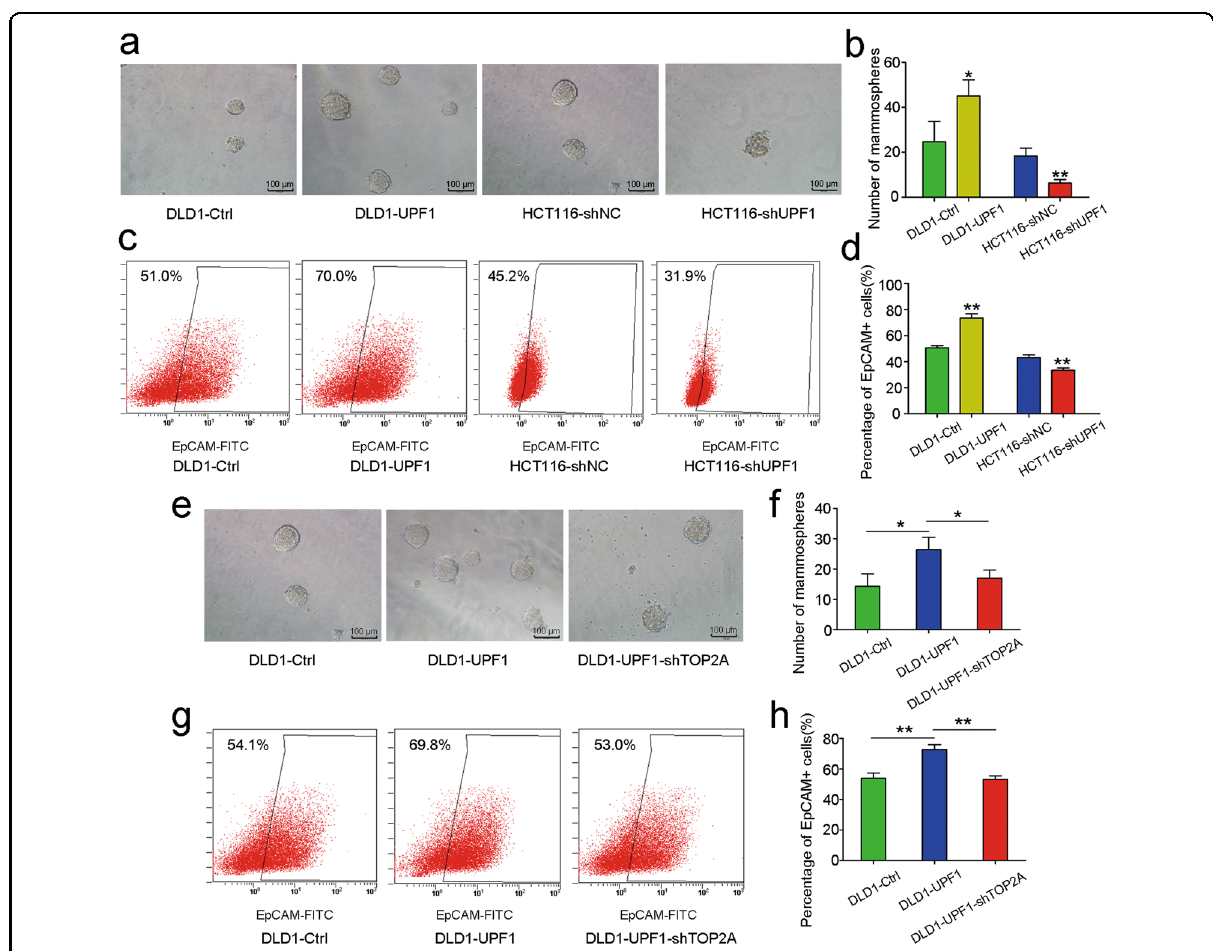
Fig. 7 UPF1 maintains stemness in CRC in a TOP2A-dependent manner. a – b The ability of mammosphere formation was enhanced after upregulation of UPF1 in DLD1 and was attenuated after knockdown of UPF1 in HCT116, scale bar, 100 μ m. c , d The percentage of EpCAM-positive cells was raised in DLD1-UPF1 and diminished in HCT116-shUPF1 compared with control. e – f Silencing TOP2A abrogated enhancement of the ability of mammosphere formation induced by UPF1, scale bar, 100 μ m. g , h Silencing TOP2A down regulated the rise of the percentage of EpCAM-positive cells induced by